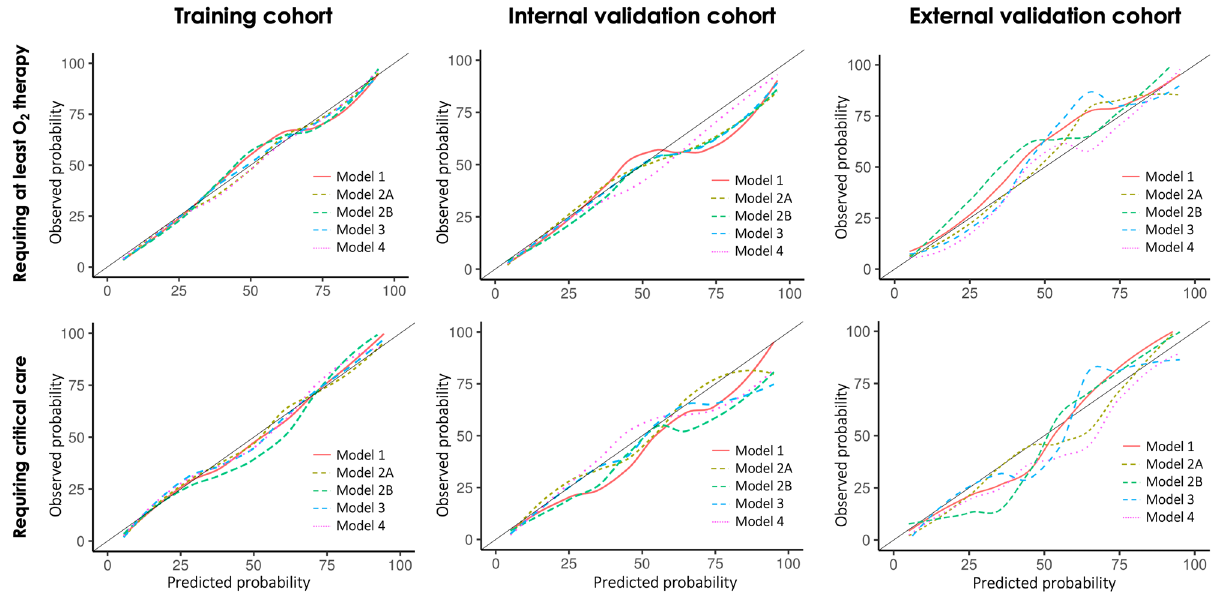
Figure 2. Calibration